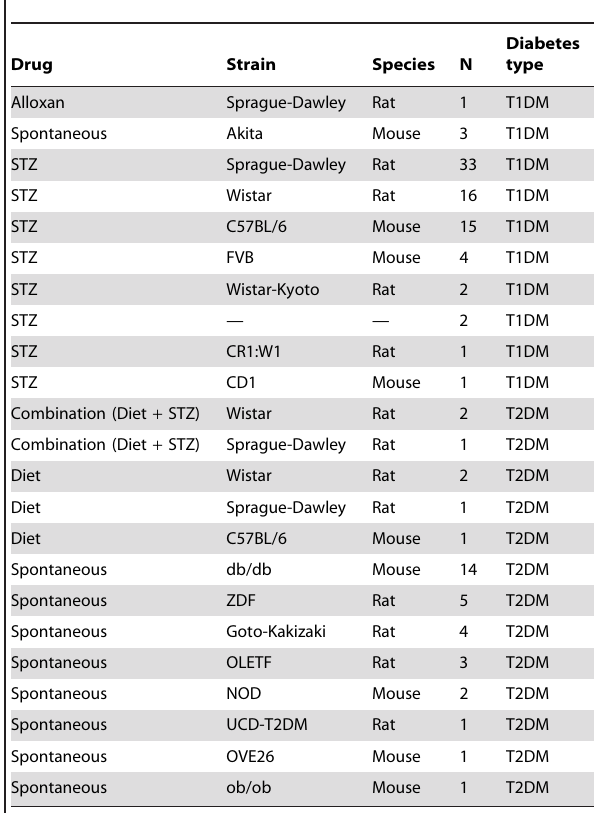
HW:BW, left ventricular weight:body weight, cardiomyocyte area, or the presence of cardiac dysfunction. The category of Table 2. Descriptive summary of rodent models of experimental